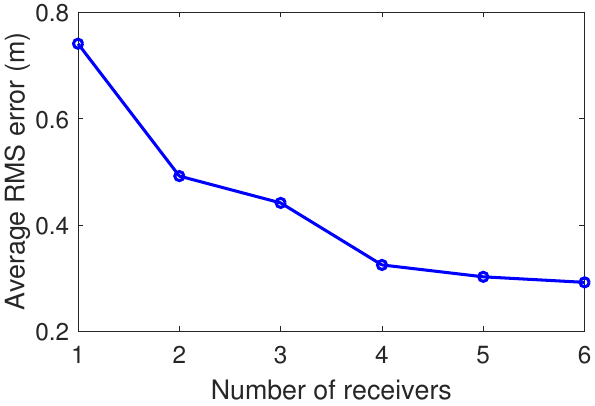
Figure 3. CDF of VLP as a function of the number of receivers. The impact of receiver separation on VLP is also investigated to select a favourable receiver spacing on the vehicle. We only consider receiver separations from 0.02 m to 0.4 m due to their practicality for real application. Figure 4 shows the CDF of the RMS error for the receiver separations of 0.02 m, 0.04 m, 0.1 m, 0.2 m and 0.4 m. At 0.95 CDF, the average RMS errors are 2.5 m, 1.86 m, 1.83 m, 1.3 m and 0.8 m, respectively. Figure 4 illustrates that the accuracy of the system increases as the receiver spacing is increased. It is noticed that only a receiver separation of 0.4 m (out of the chosen values) provide an RMS error below 1 m at 0.95 CDF. Hence, the separation between the receivers of 0.4 m is selected for further simulations.